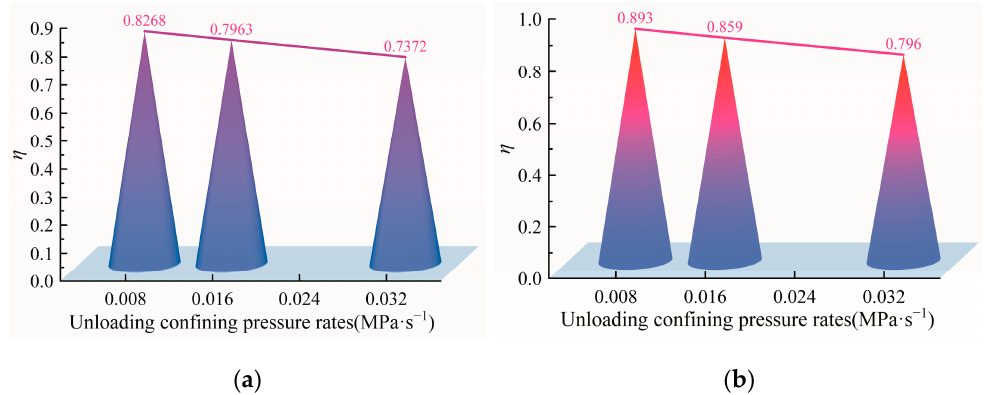
Figure 8. Effect of unloading confining-pressure rate on the nonlinear mechanical behavior of the diorite strain energy sequence: ( a ) critical values of period-doubling bifurcation; ( b ) chaotic critical values.